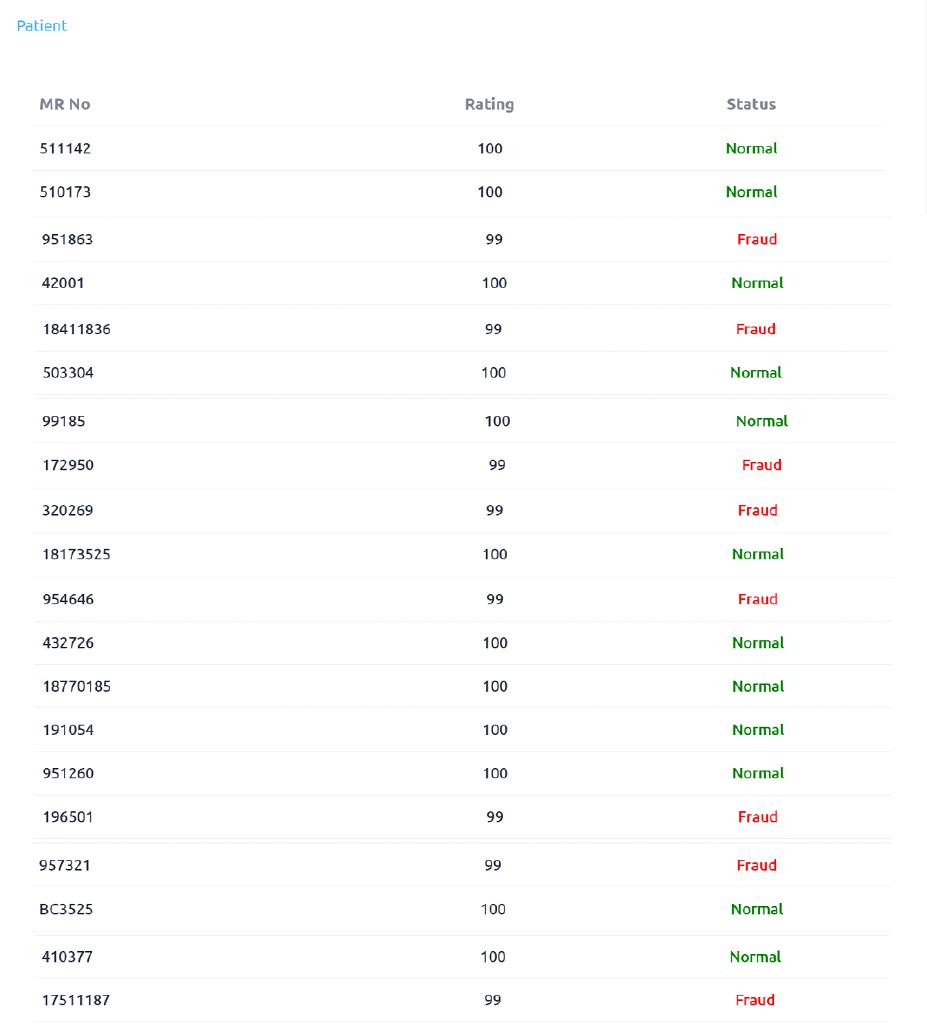
Figure 17. Doctor_id 551 initial rating in First phase.